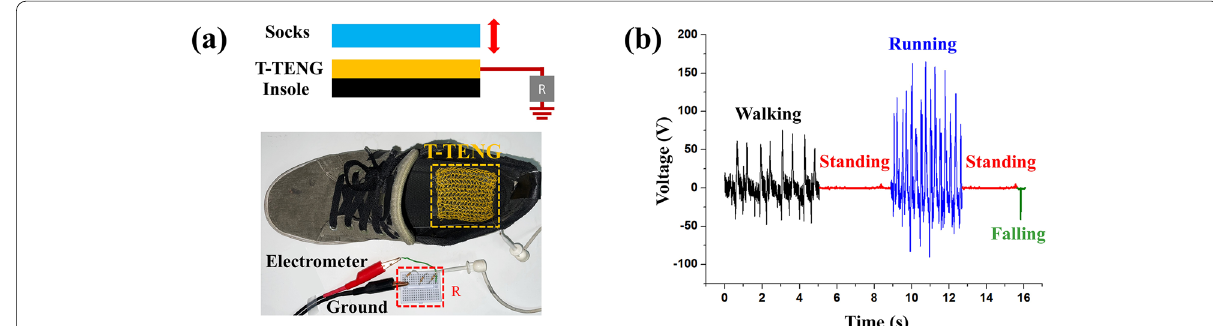
Fig. 5 a Photograph of a shoe with T‑TENG integrated in the insole and a schematic diagram of the energy harvesting mechanism. b Output voltage of T‑TENG measured when walking, standing, running and falling at 30